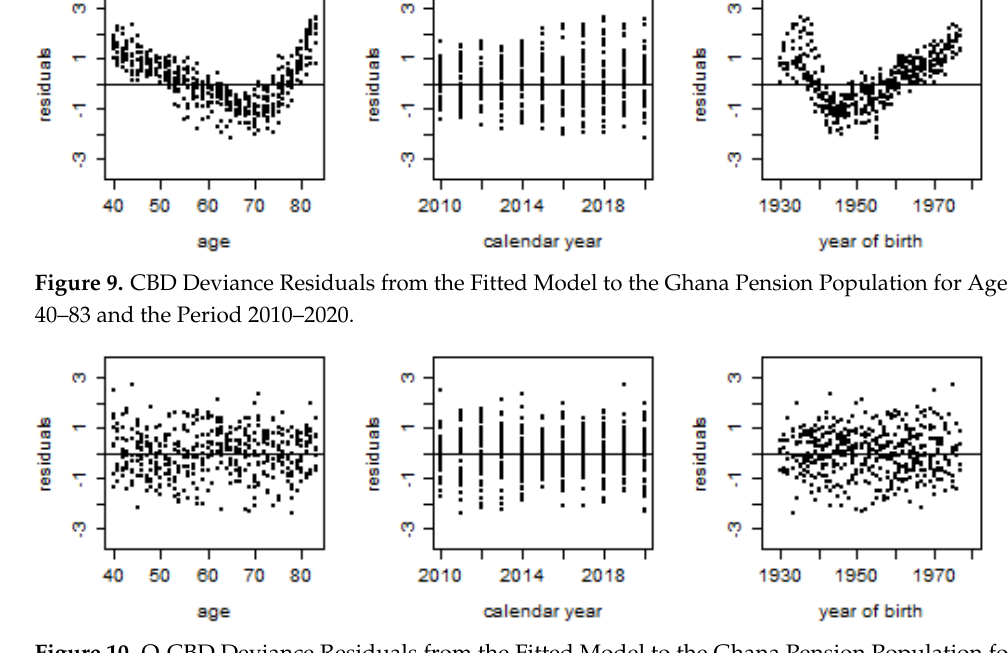
Figure 10. Q-CBD Deviance Residuals from the Fitted Model to the Ghana Pension Population for Ages 40–83 and the Period 2010–2020.